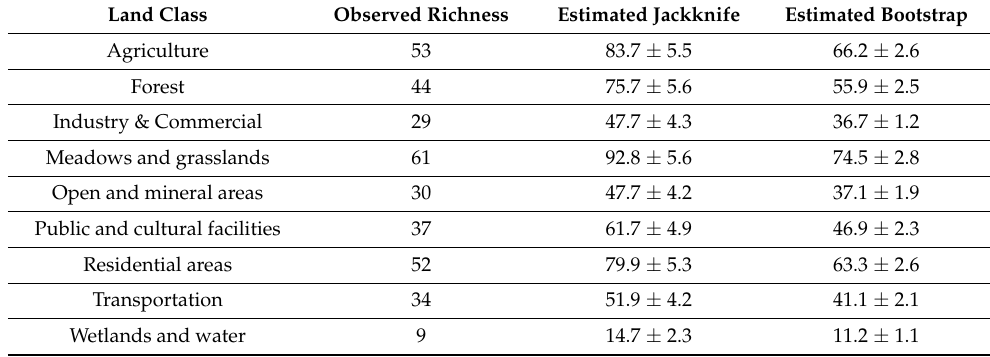
Table 3. Observed and estimated species richness (number of genera) by land-use